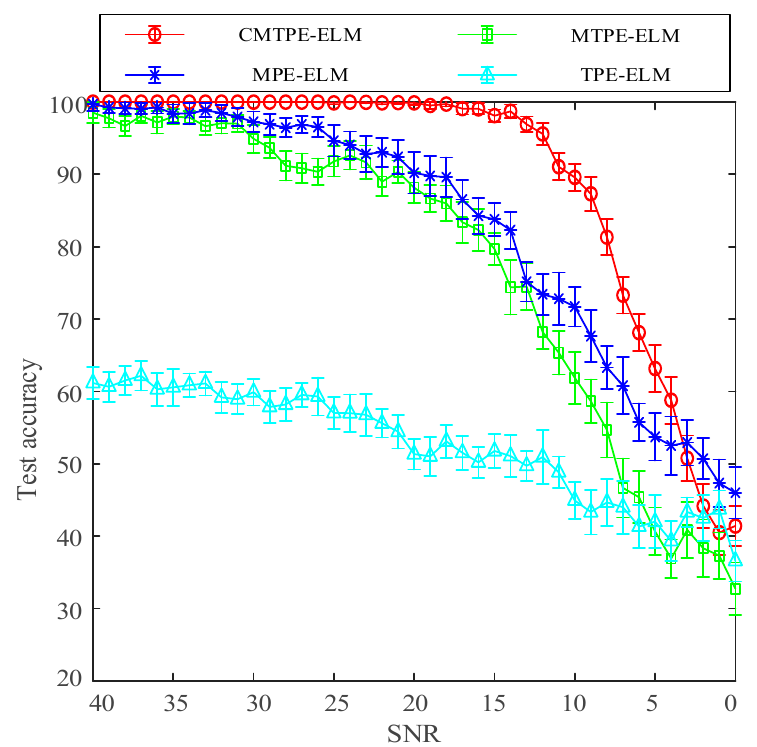
Figure 5. Test results with different SNR